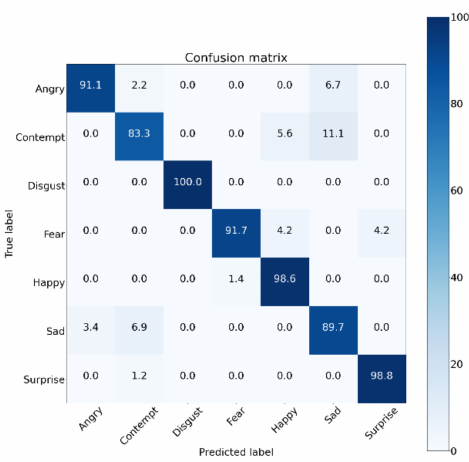
Figure 5. Confusion matrix of our DGNN method for the CK + dataset.